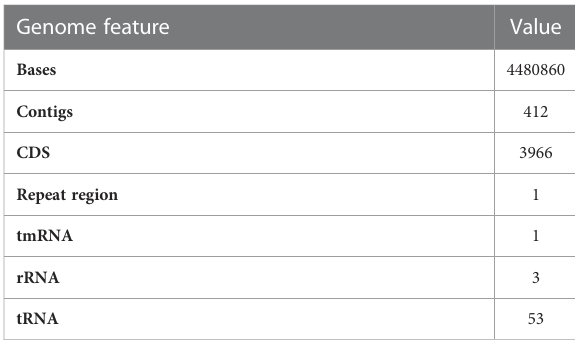
TABLE 2 PROKKA annotated genome features of Cellulomonas sp.